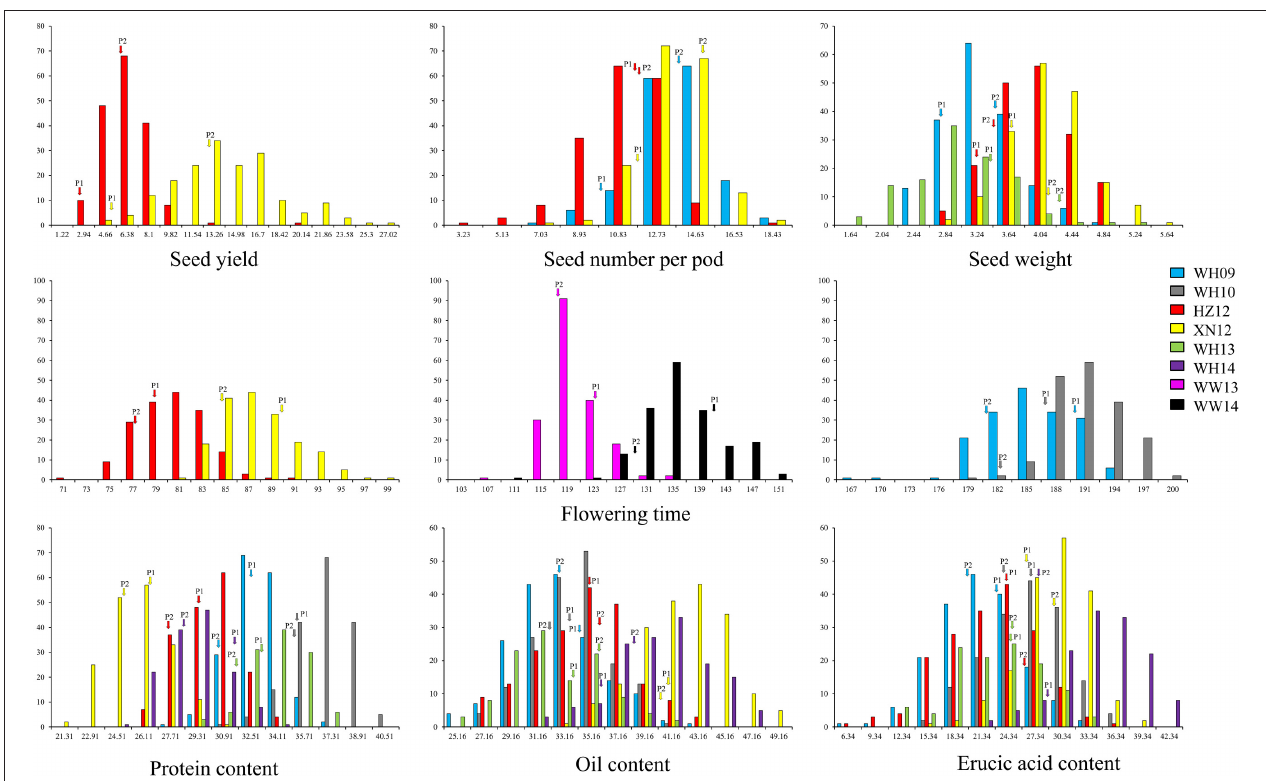
FIGURE 4 | The frequency distribution of representative traits in YW DH population. Seed yield with three seed yield related traits and three seed quality traits were showed in this figure. P1 and P2 represent the two parents Y-BcDH64 and W-BcDH76, respectively. Transgressive segregation was observed in the population from all the